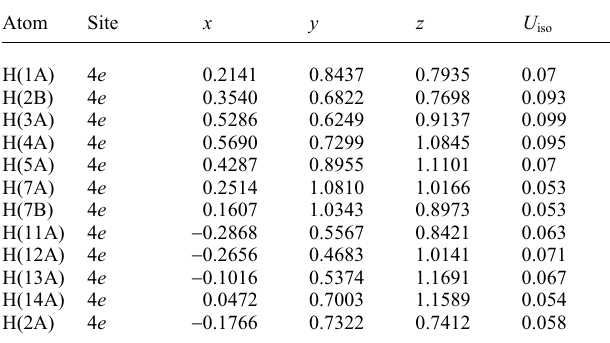
Table 2. Atomic coordinates and displacement parameters (in Å 2 )